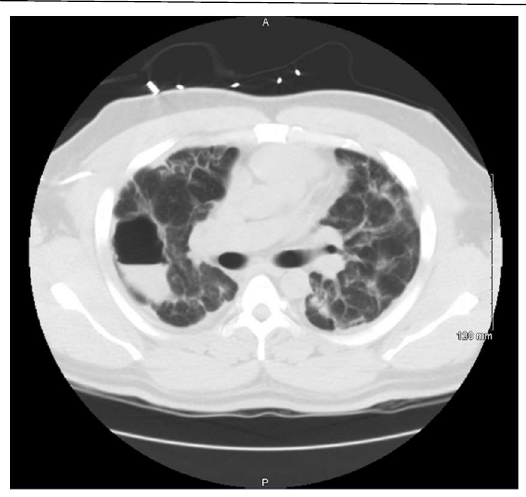
Figure 3. Non-contrast CT scans showing resolution of the pneumothorax. Laterally in right upper lobe, there is oval-shaped lucent lesion measuring 7 cm (AP) x 4.6 cm (transverse) x 2.5 cm (cc). Wall is thin and barely perceptible. Inner margin of the cavity is smooth. There is an internal air-fluid level. It is difficult to tell if this collection is tracking along the minor fissure. Numerous scattered ground-glass pulmonary opacities are present throughout each